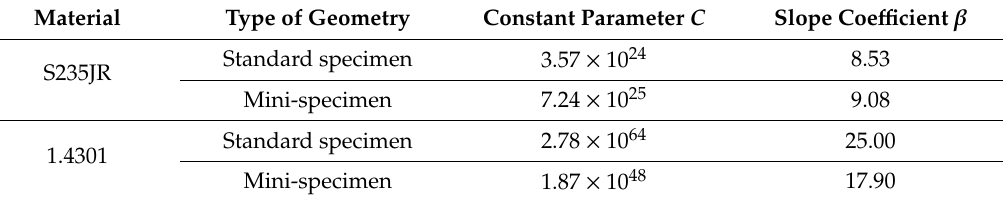
Table 5. Values of the Basquin model.